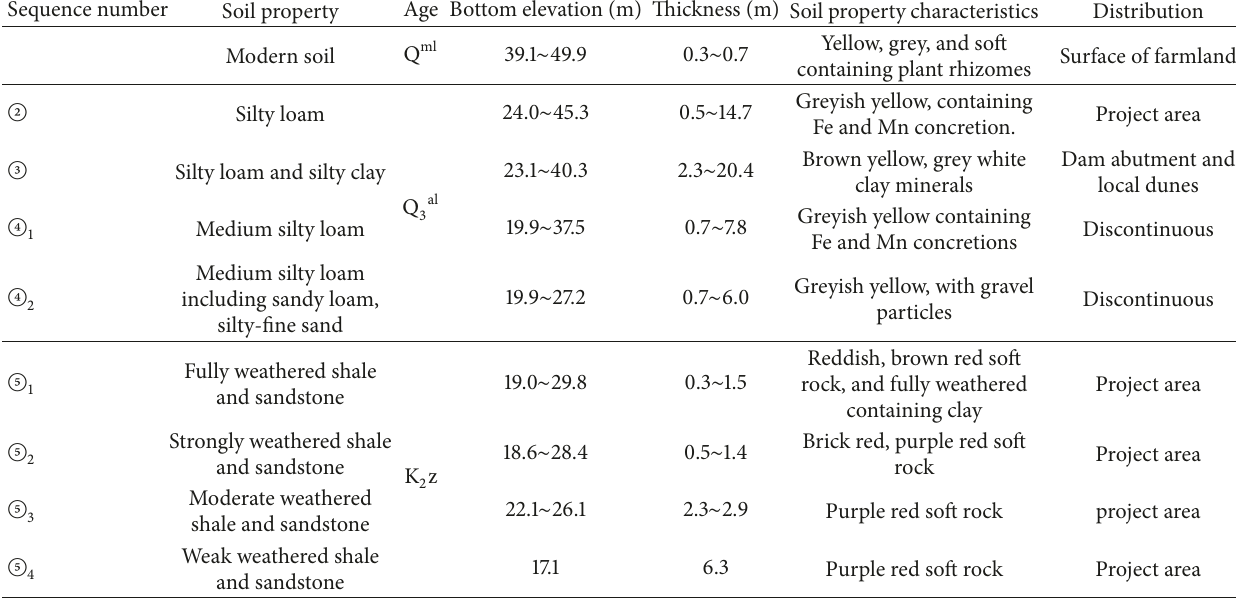
Table 1: Strata in the study area: key